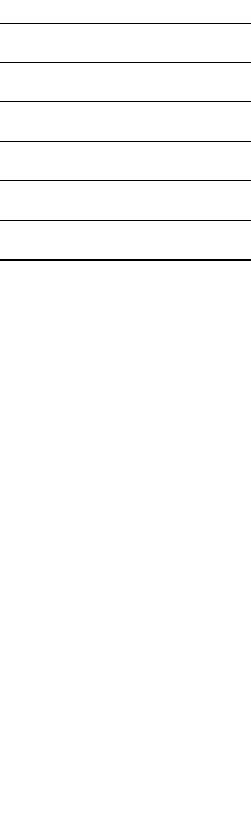
Table 3. Aspects of household decision-making power in Jimma Zone, Western Ethiopia in 2020. Decision-Making Dimension (N = 746)